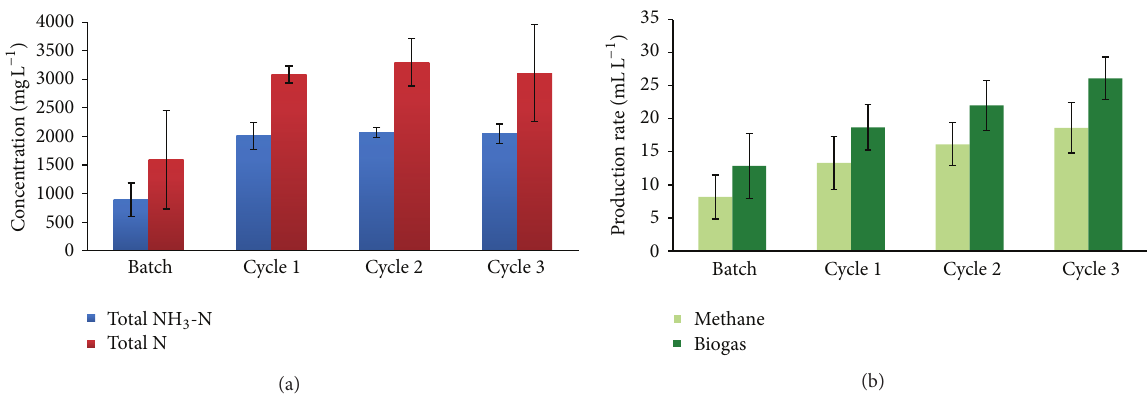
Figure 2: (a) Total nitrogen and NH 3 -N concentrations and (b) methane and total biogas production rates during batch and semicontinuous operation. The data are averages with standard deviations of three or more measurements during each operating phase.